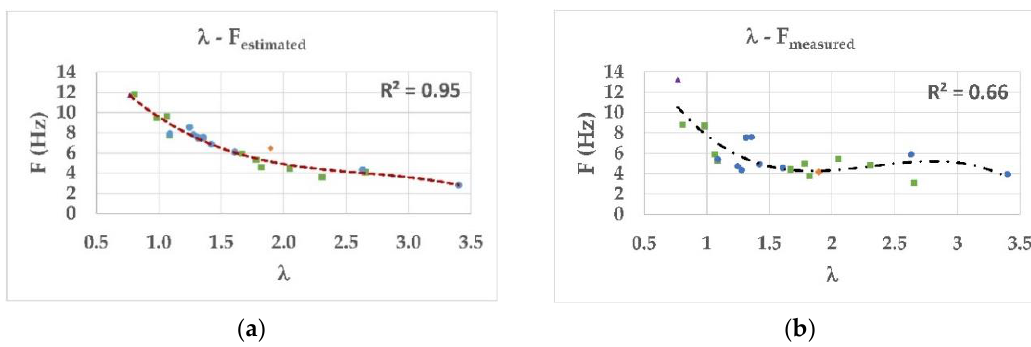
Figure 21. Comparison between ( a ) the slenderness ( λ ) and the estimated natural frequency; and ( b ) slenderness and measured natural frequency. Green square: cube-shaped; blue circle: cylindrical; orange diamond: Agicampe tower (oval); purple triangle: